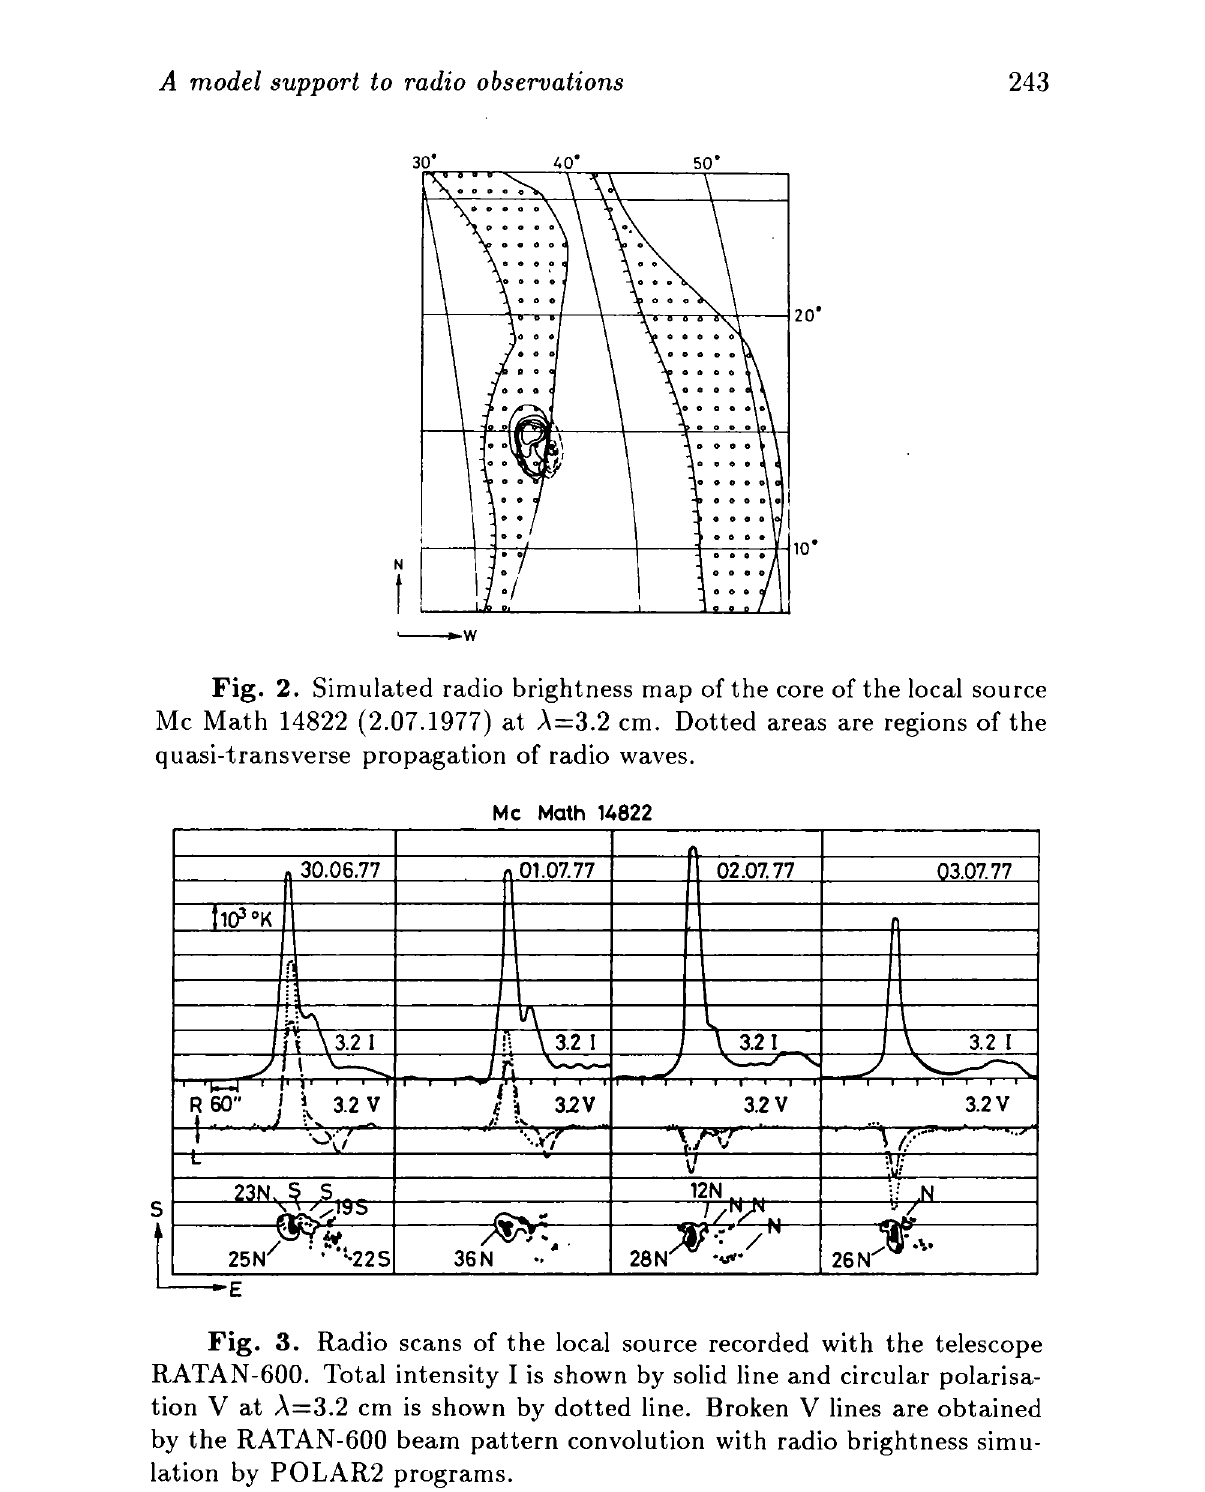
Fig. 3. Radio scans of the local source recorded with the telescope RATAN-600. Total intensity I is shown by solid line and circular polarisa- tion V at A=3.2 cm is shown by dotted line. Broken V lines are obtained by the RATAN-600 beam pattern convolution with radio brightness simu- lation by POLAR2